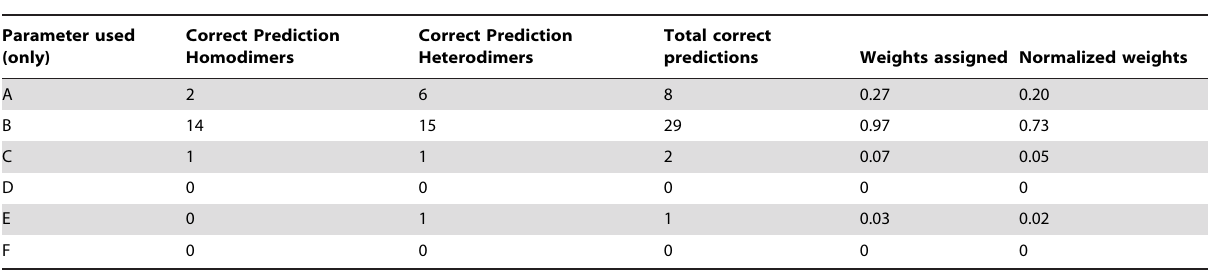
Table 3. Weights assigned to different parameters using one parameter at a